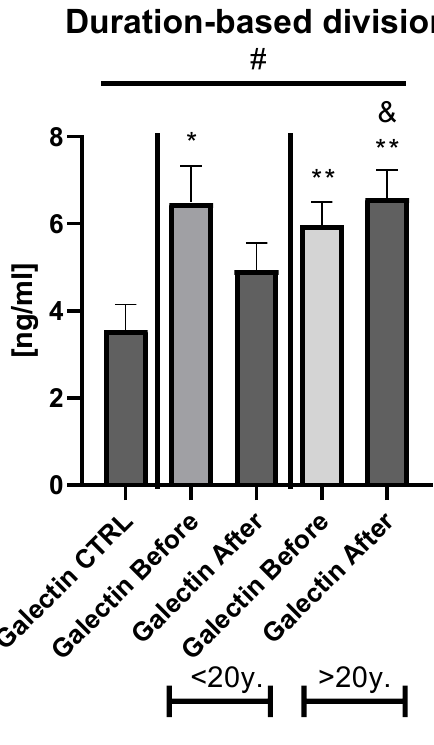
Figure 3. The levels of gal-3 in psoriatics before and after total treatment compared to control group depending on the duration of psoriasis. */**—means the existence of statistically significant difference between patients single group compared to control group with p < 0.05; <0.01, respectively. &—means the existence of trend ( p < 0.1) between <20 y. and >20 y. subgroups after treatment #—shows the statistical significance between control group and marked patients subgroups when compared using ANOVA with p < 0.05 and mean trend.